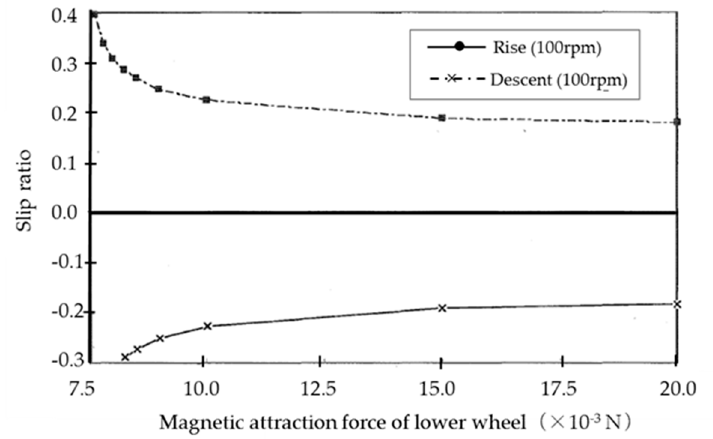
Figure 11. Relationship between the slip ratio and the magnetic attraction force of the lower wheels when climbing and descending at 100 rpm. For both climbing and descending, the slip ratio decreases as the gripping force increases with the increase in the magnetic attraction force of the lower wheels. Since the slip ratio was observed to converge to a particular value, the climbing velocity converges not to the theoretical velocity.